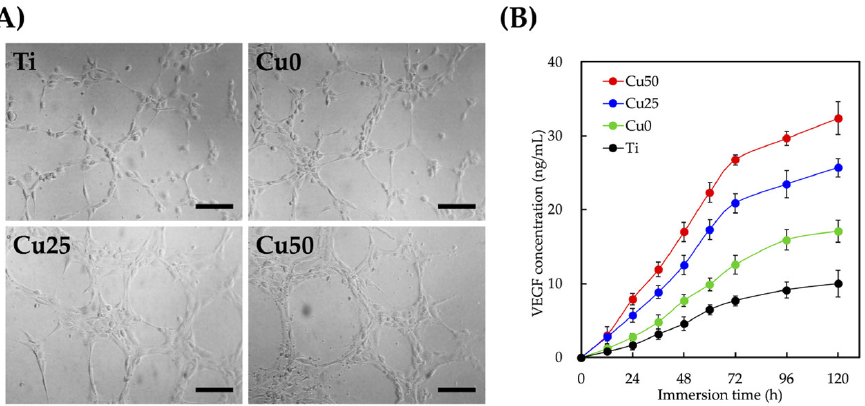
Figure 8. ( A ) Tube formation assay of HUVEC with different extracts treatment. Scale bar = 100 μm. ( B ) VEGF secretion from HUVEC cultured with different extract for 5 days. Data are presented as mean ± SEM, n = 6 for each group.